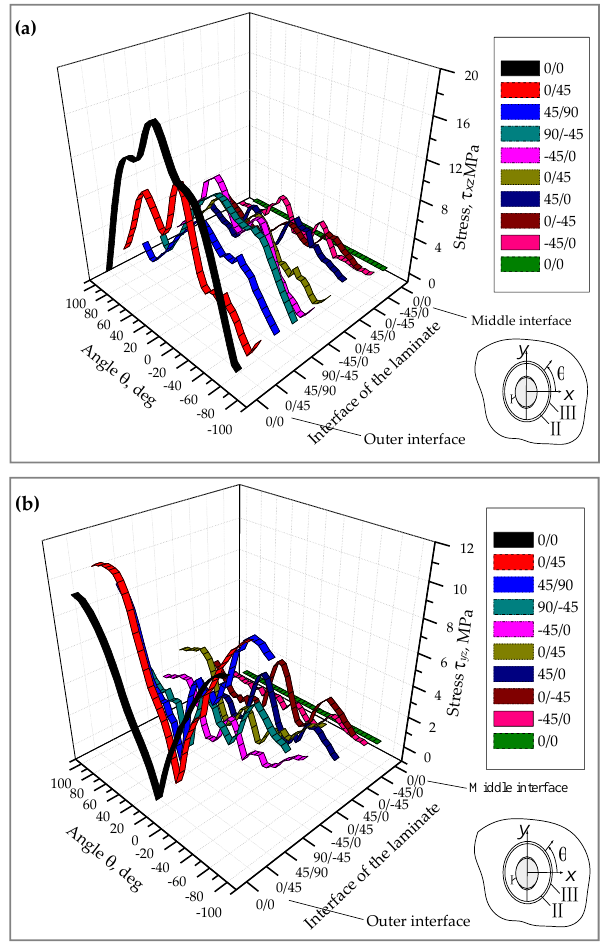
Figure 8. Interlaminar shear stress distributions around Position III: ( a ) τ xz ; ( b ) τ